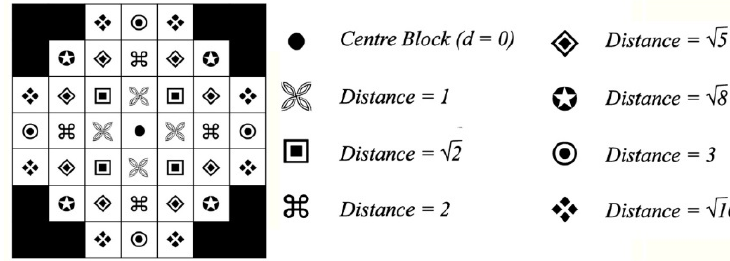
Figure 7. ( a ) Unit distance representation of the block. ( b ) Diagonal neighbors at √2 from b. They are at Euclidean distance of